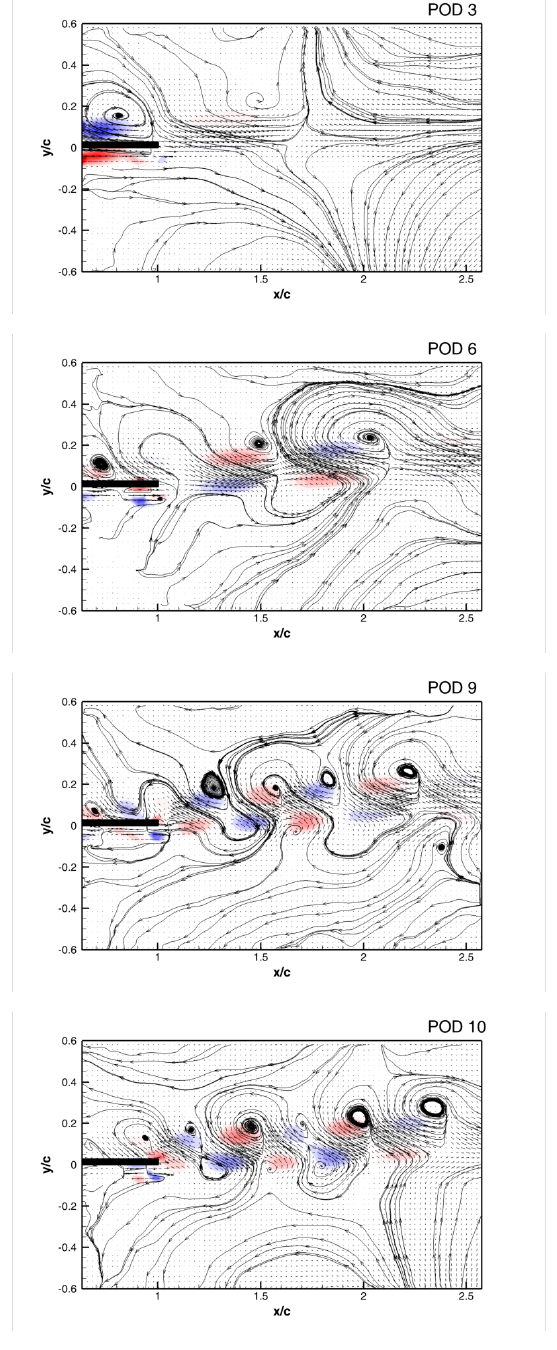
Fig. 7. Some examples of POD evaluated for the wake behind the flat plate